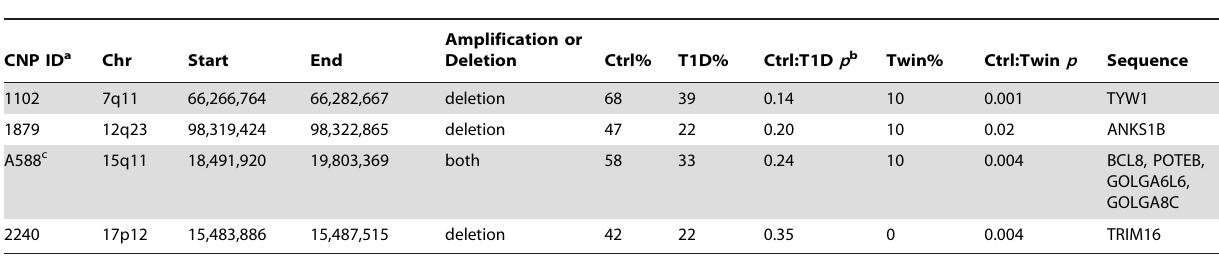
Table 2. CNVs depleted in T1D and Twin cohorts, relative to